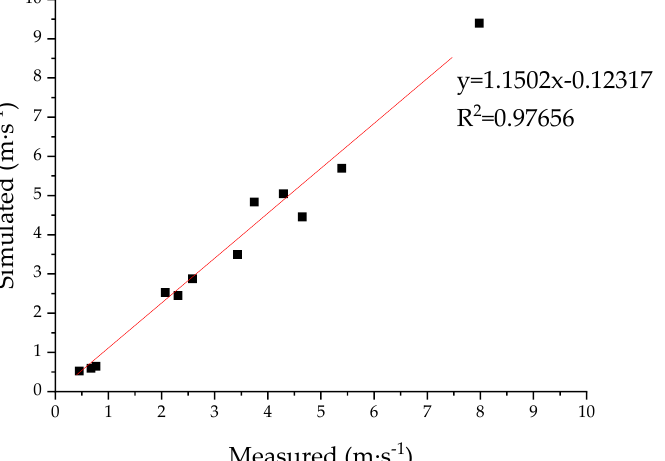
Figure 11. The regression analysis of the experimental values and simulated values of the air speed in the canopy.